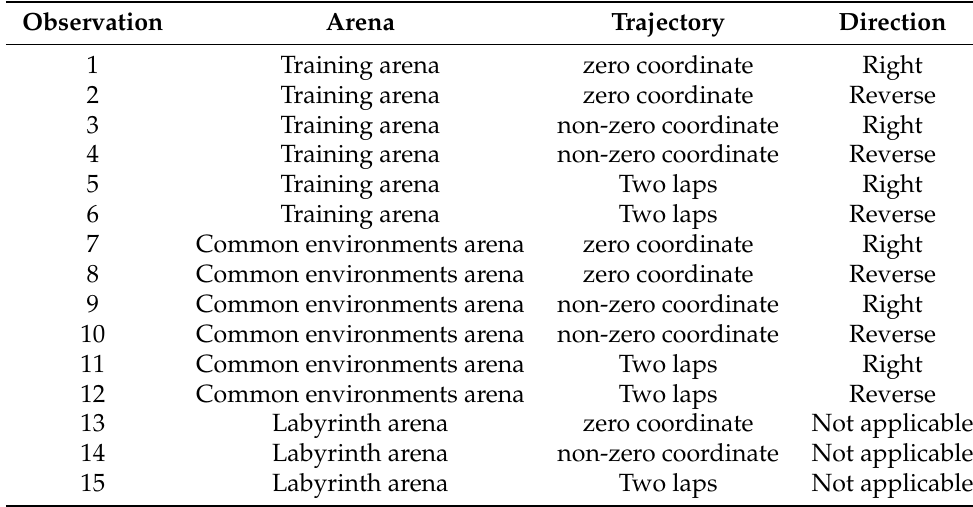
Table 6. Observation translation to